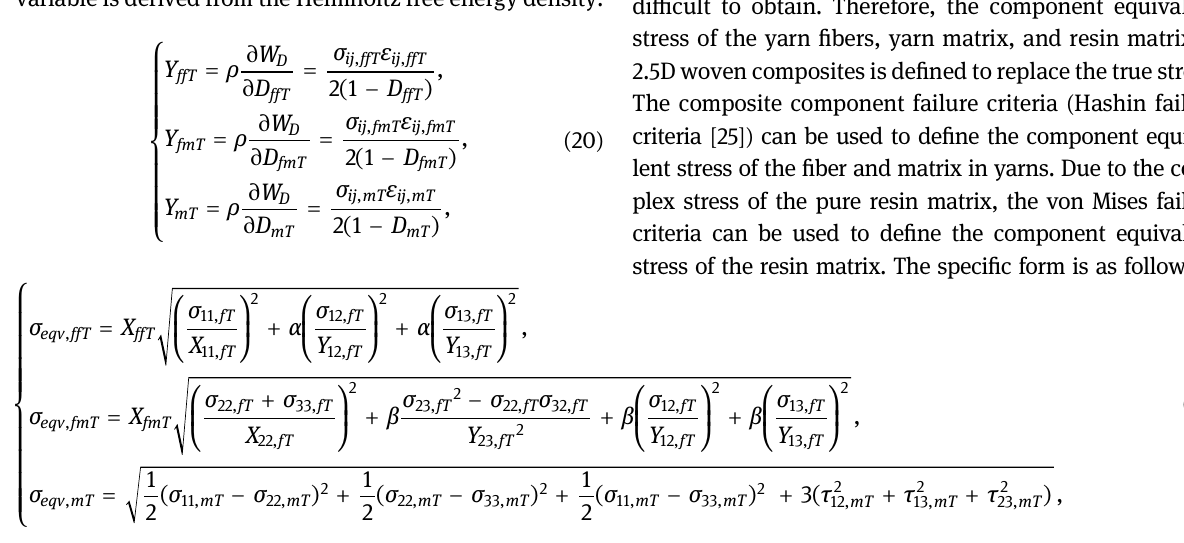
where X ffT and X fmT are the fi ber and matrix strengths of the yarns, respectively. X fT 11, and X fT 22, are the longitu - dinal and transverse tension strengths of the yarns, respectively. Y fT 12, , Y fT 13, , and Y fT 23, are the shear strengths of the yarns in the material coordinate system. α and β are the shear contribution factors. By substituting equa - tion ( 23 ) into equation ( 22 ) , the damage evolution equation for the fatigue life prediction of 2.5D woven composites can be